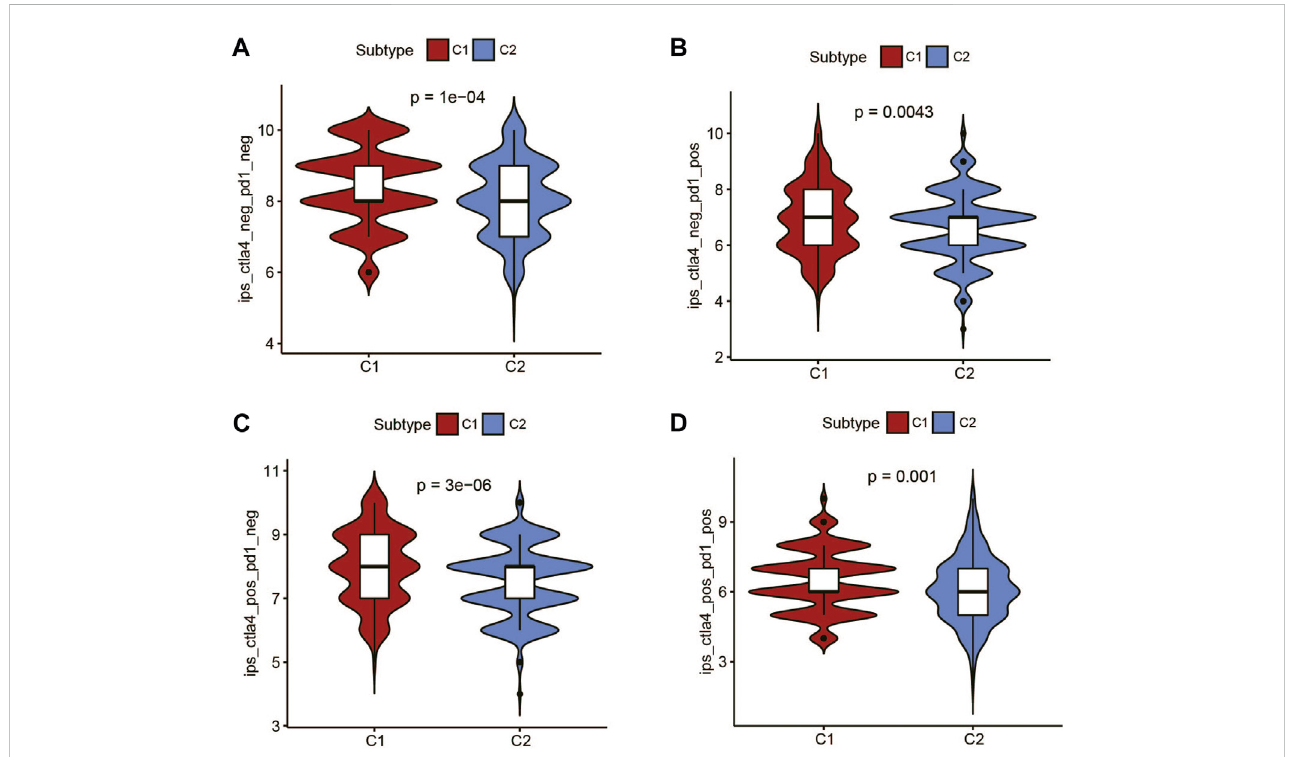
FIGURE 5 The association between IPS and the metabolic subtypes of UCEC patients. (A) IPS of ctla4_neg_pd1_neg in C1 and C2 subtypes. (B) IPS of ctla4_neg_ pd1_pos in C1 and C2 subtypes. (C) IPS of ctla4_pos_pd1_neg in C1 and C2 subtypes. (D) IPS of ctla4_pos_pd1_pos in C1 and C2